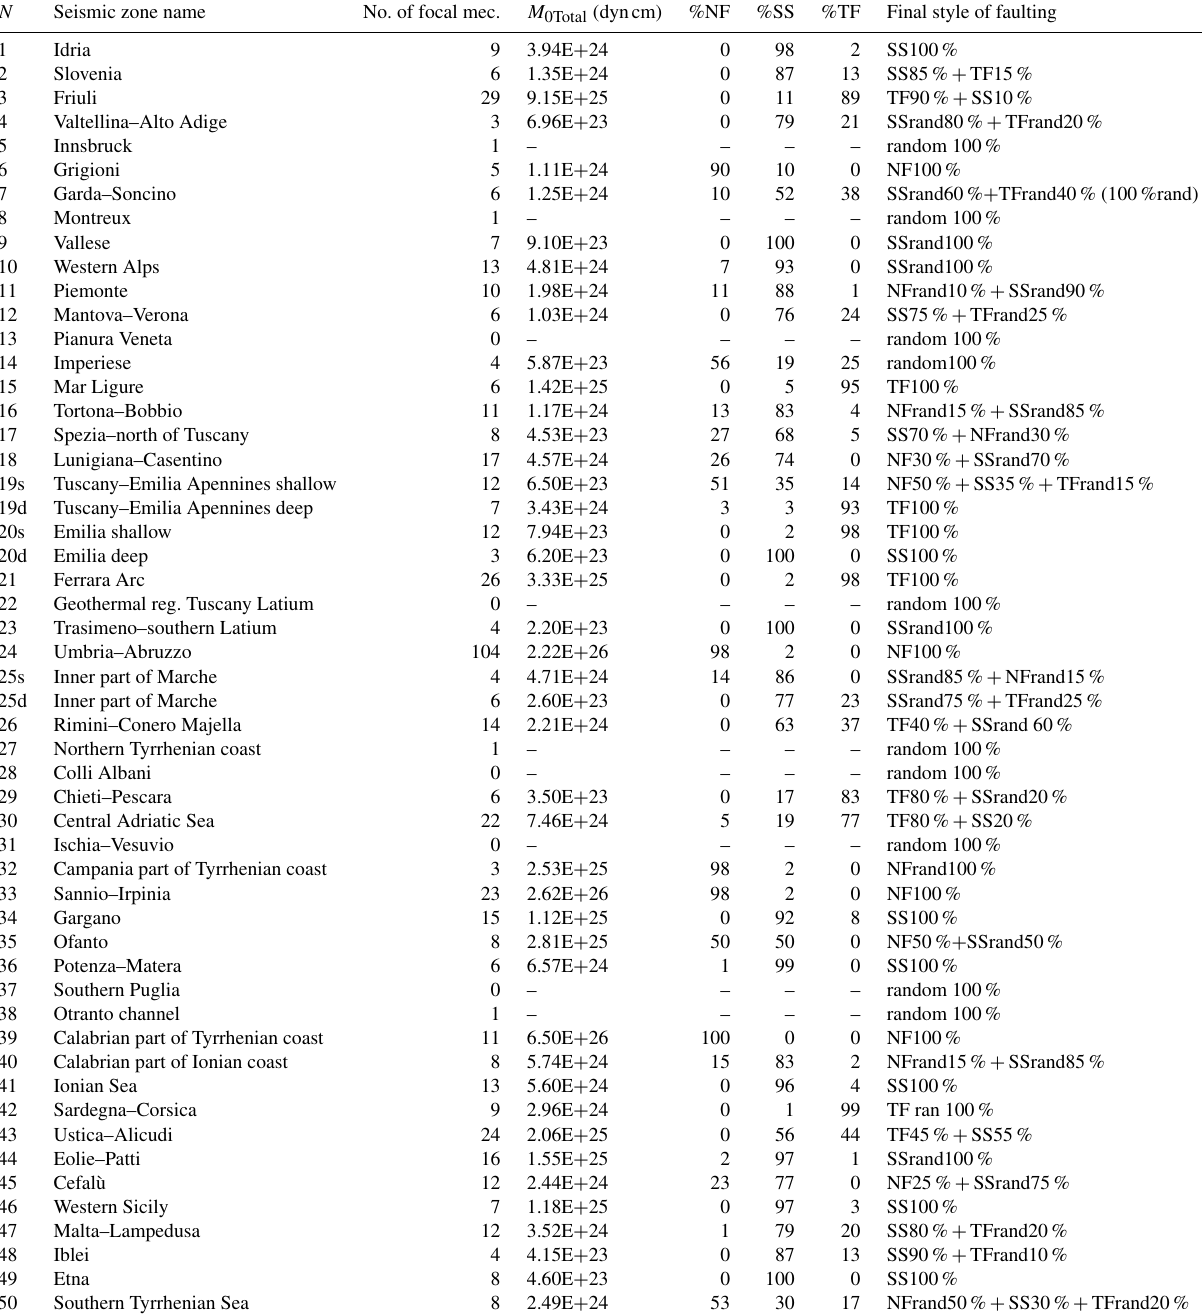
Table 3. Final style of faulting for each seismic zone, with the total number of focal mechanisms used, the total released seismic moment M 0Total per zone, and the percentage of contribution of each tectonic style to the final